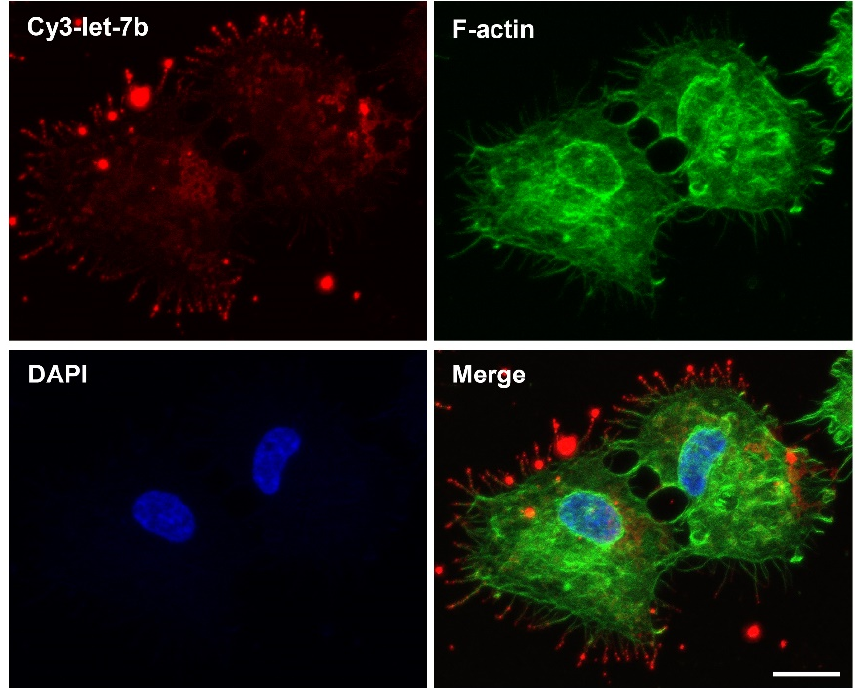
Figure 3. RD3AD peptide-mediated localization of complexed let-7b miRNAs to filopodia and delivery into cancer cells. Confocal fluorescence microscopy analysis of CAL 27 oral cancer cells 2 h post-treatment with a synthetic Cy3-labeled let-7b miRNA duplex (Cy3-let-7b; red) in complex with the RD3AD peptide. Filopodia (green) were stained with the F-actin label Alex Fluor 488 phalloidin, and nuclei (blue) were counterstained with DAPI. The merged images are also presented. Scale bar: 15 µm. For details on materials and methods used, please see Supplementary Materials.